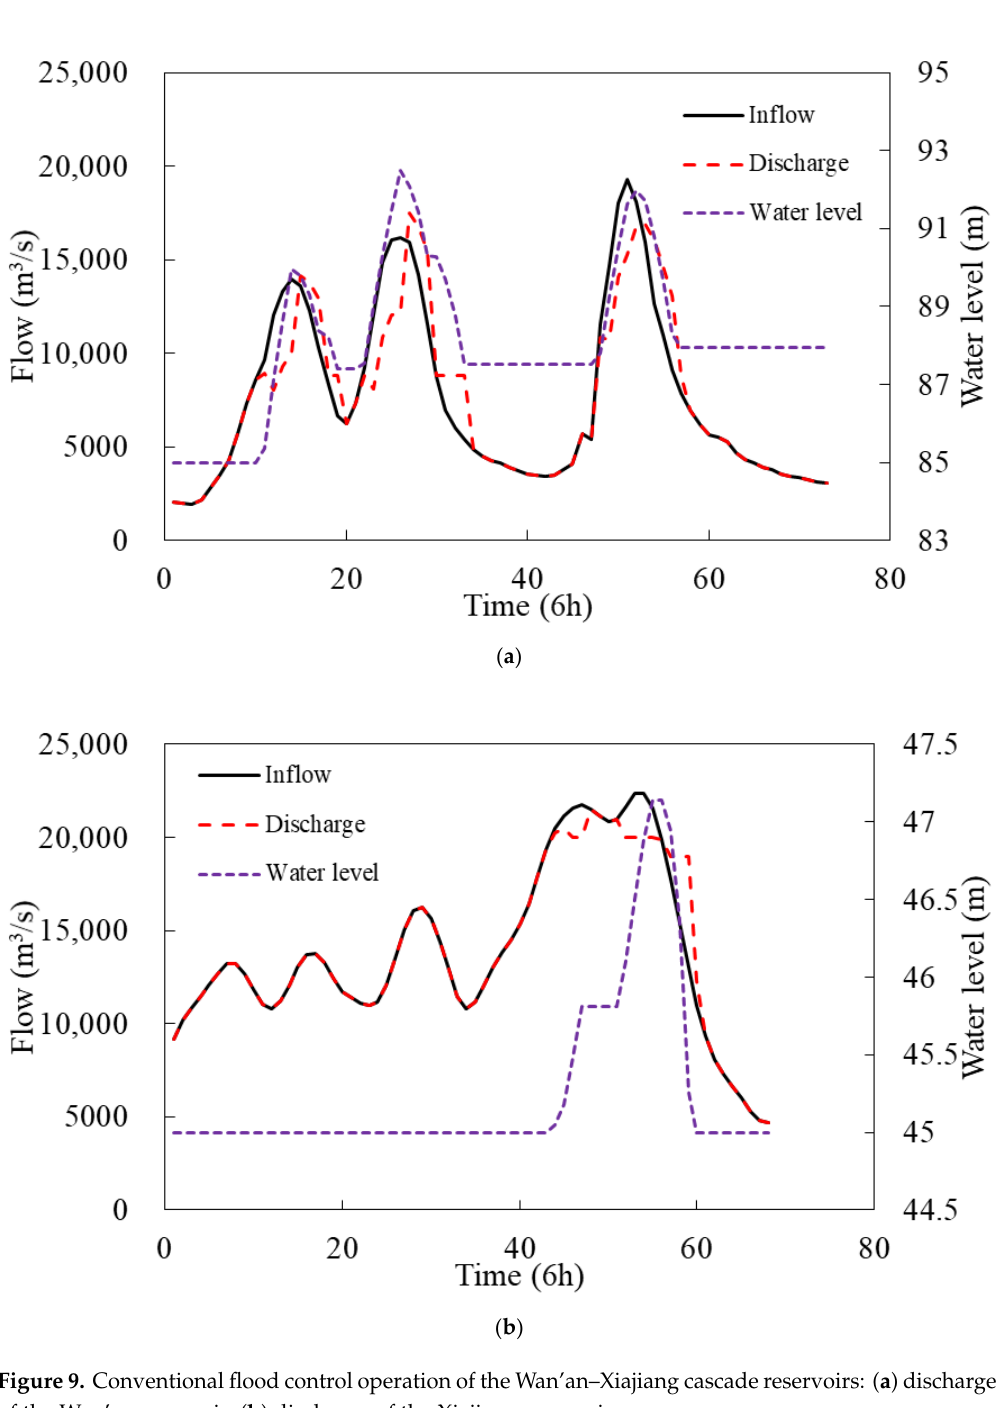
Figure 9. Conventional flood control operation of the Wan’an–Xiajiang cascade reservoirs: ( a ) discharge of the Wan’an reservoir; ( b ) discharge of the Xiajiang reservoir.